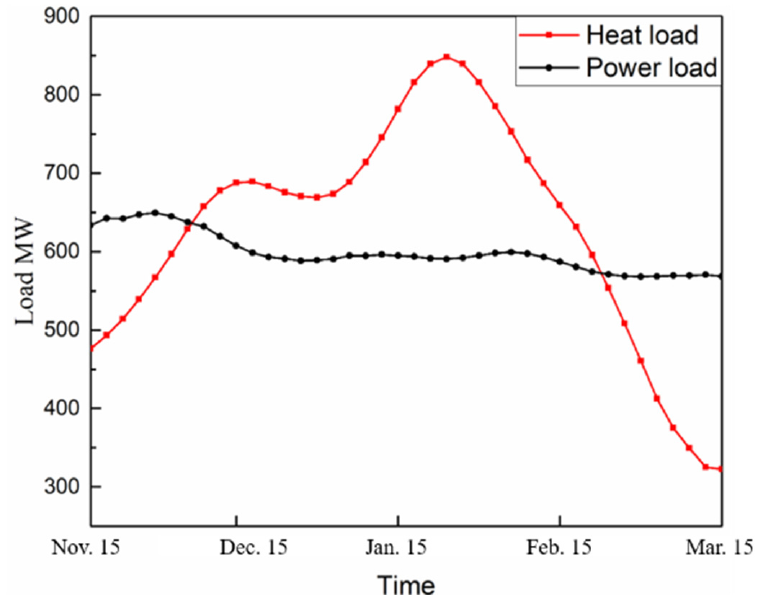
Figure 9. Loads of the case CHP system during a heating season.